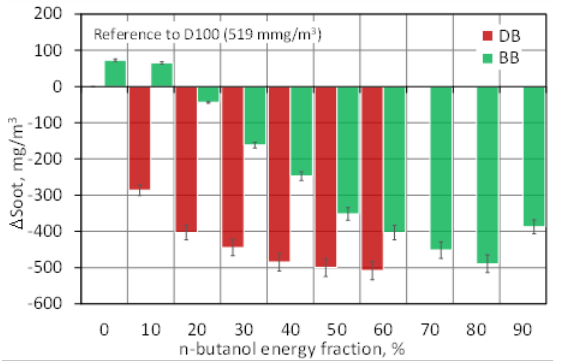
Figure 21. Soot emission for test engine powered by diesel/n-butanol and RME biodiesel/n-butanol